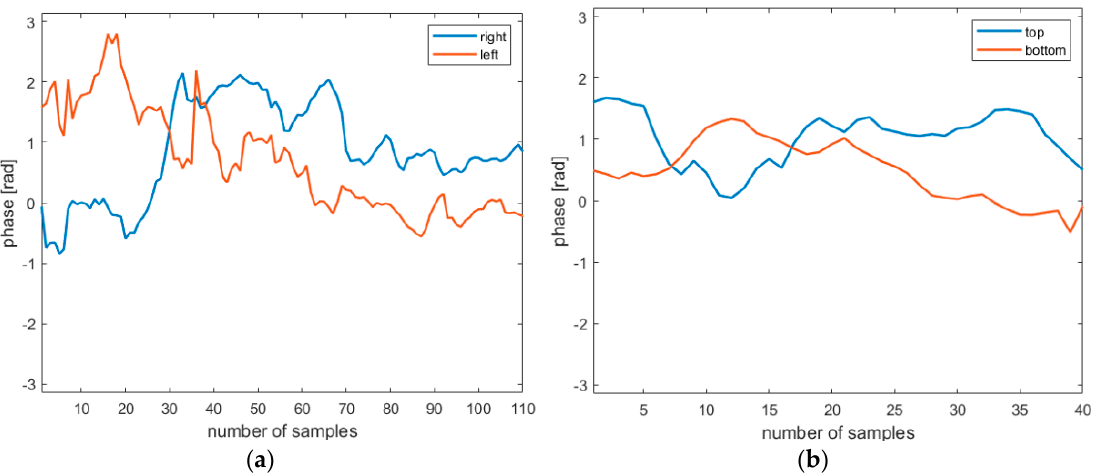
Figure 14. ( a ) Right and left side profiles of the fence phase; ( b ) top and bottom side profiles of the fence phase.